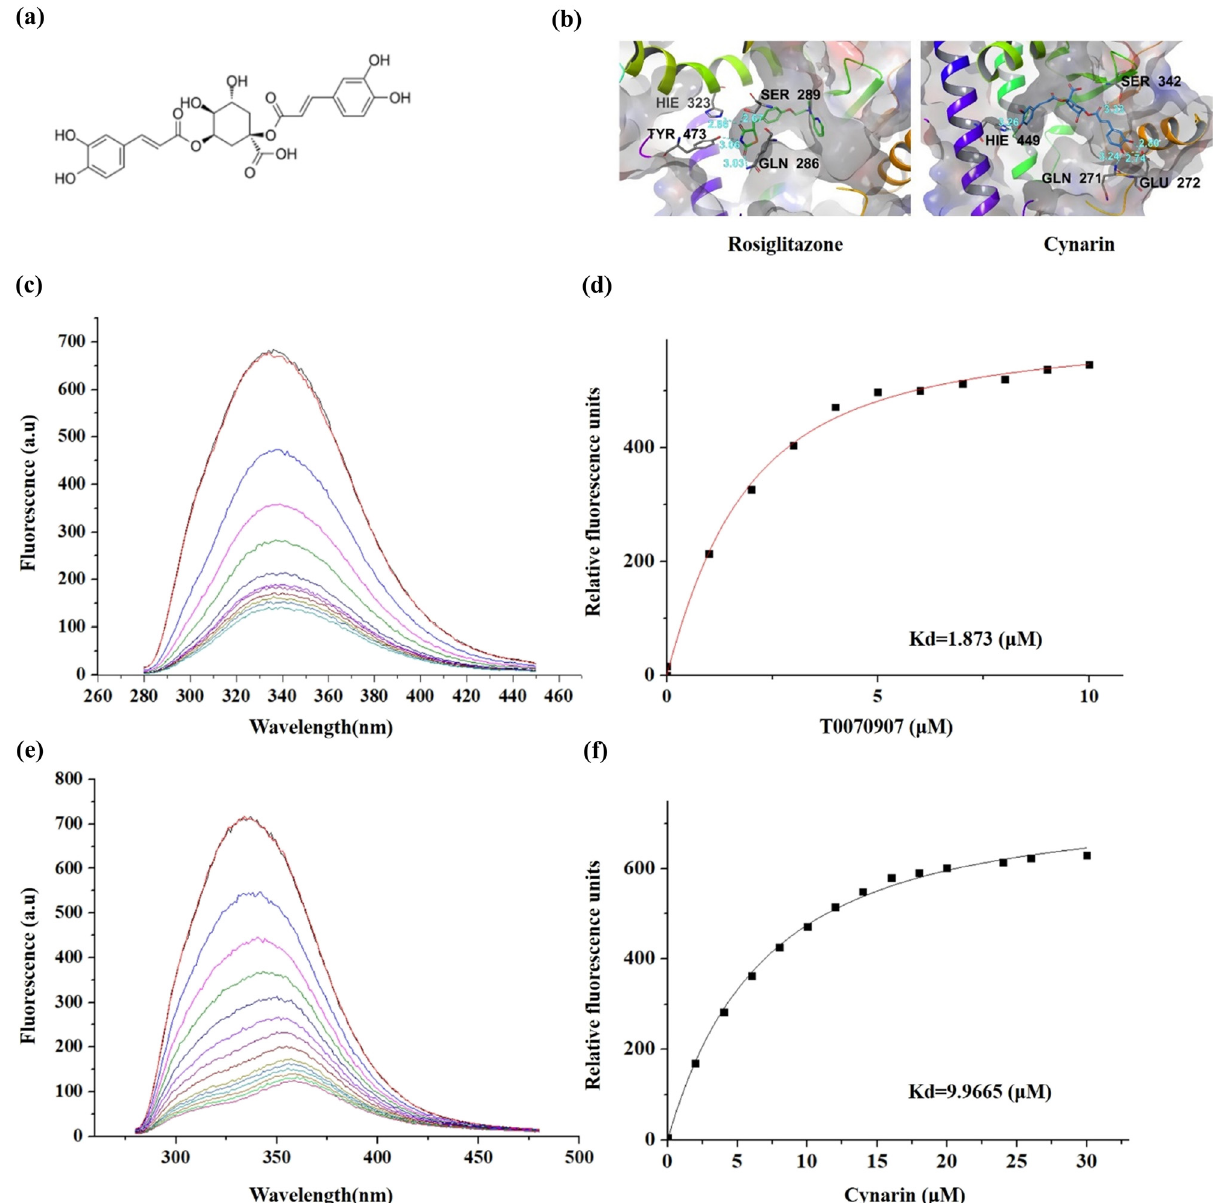
Figure 1: Cynarin binds to PPAR γ . ( a ) Molecular structure of cynarin. ( b ) Interactions of ROS and cynarin, respectively, with the PPAR γ ligand - binding pocket. ( c and d ) Fluorescence titration assay of T0070907 binding to PPAR γ - LBD. ( e and f ) Fluorescence titration assay of cynarin binding to PPAR γ -